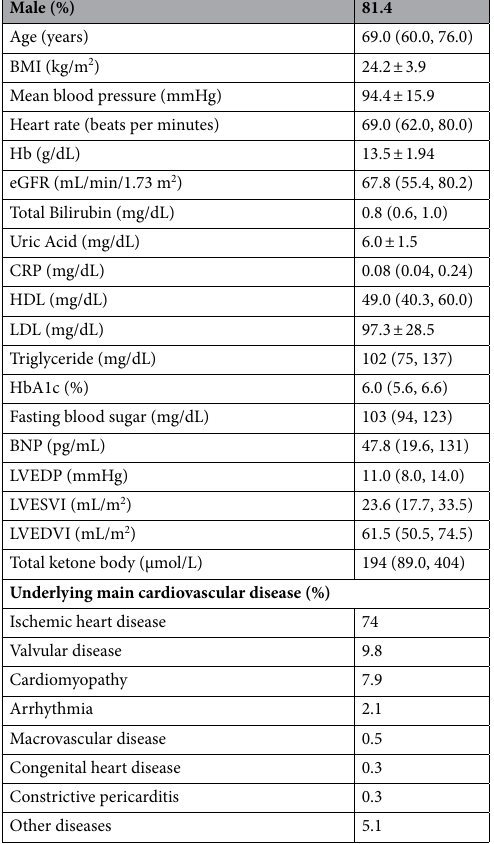
Table 1. The clinical characteristics of the patients (n = 1030). BMI body mass index, Hb hemoglobin, eGFR estimated glomerular filtration rate, CRP C-reactive protein, HDL high-density lipoprotein cholesterol,